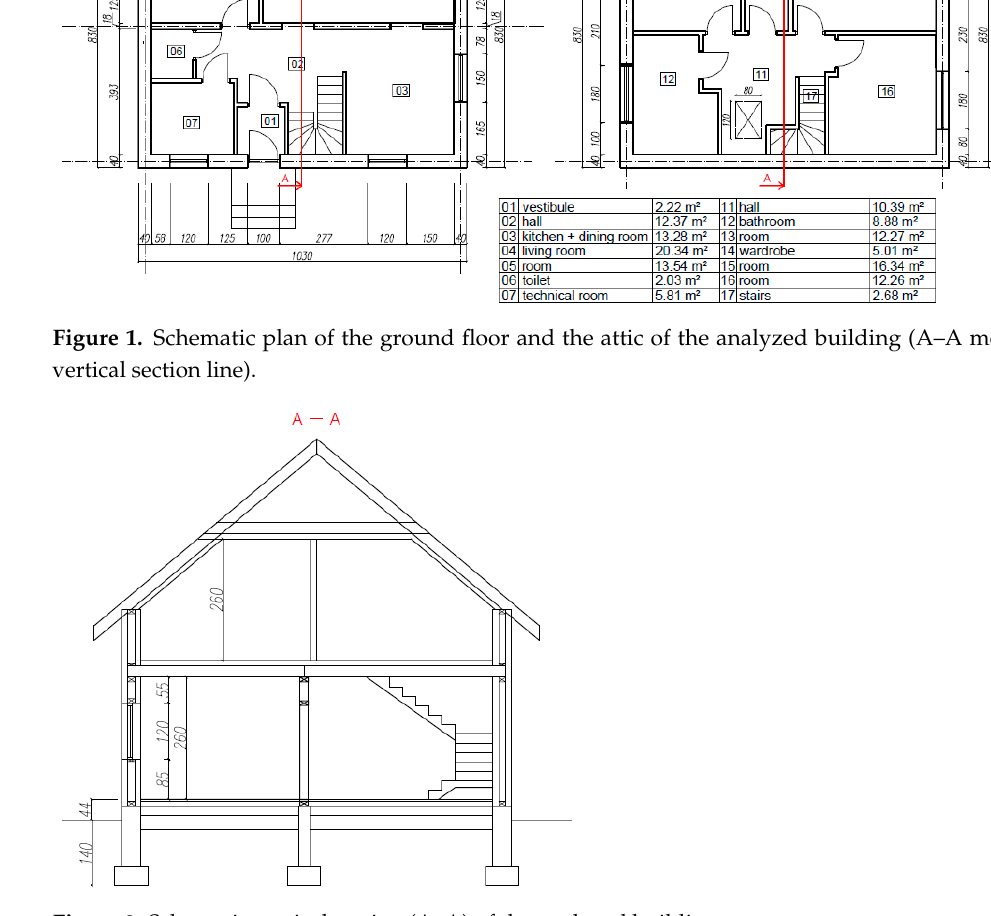
Figure 2. Schematic vertical section (A–A) of the analyzed building .